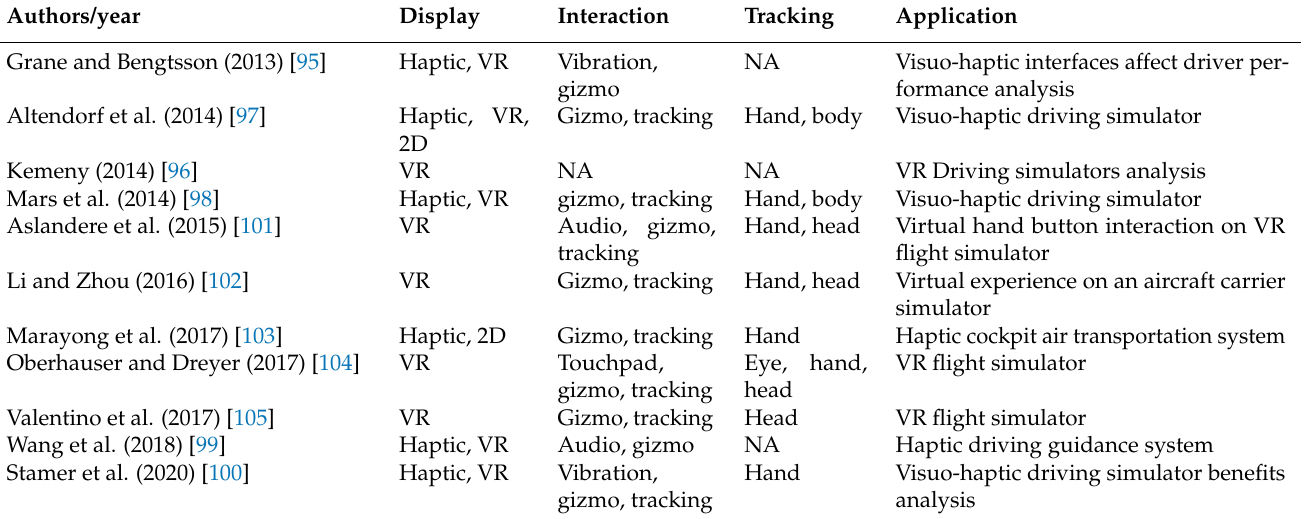
Table 6. Data table of the transportation